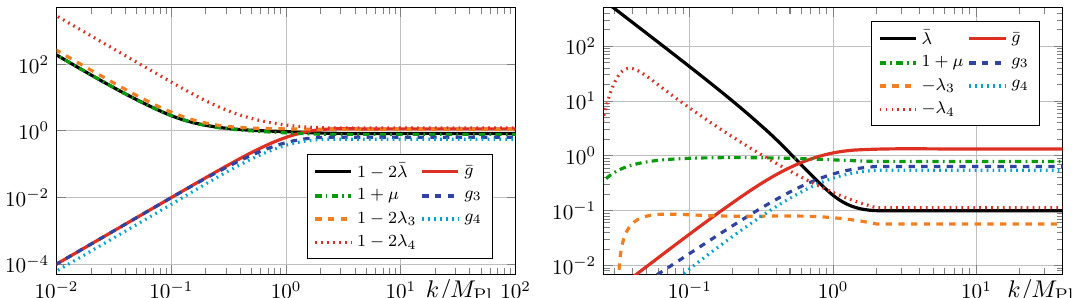
Fig. 5 Examples of UV finite trajectories from the UV fixed point (34) towards the IR. In the left panel all couplings scale classically below the Planck scale and reach their UV fixed point values shortly above the Planck scale. In the right panel some couplings show non- classical behaviour even below the Planck scale, which is triggered by the graviton mass parameter μ flowing towards the pole of the graviton